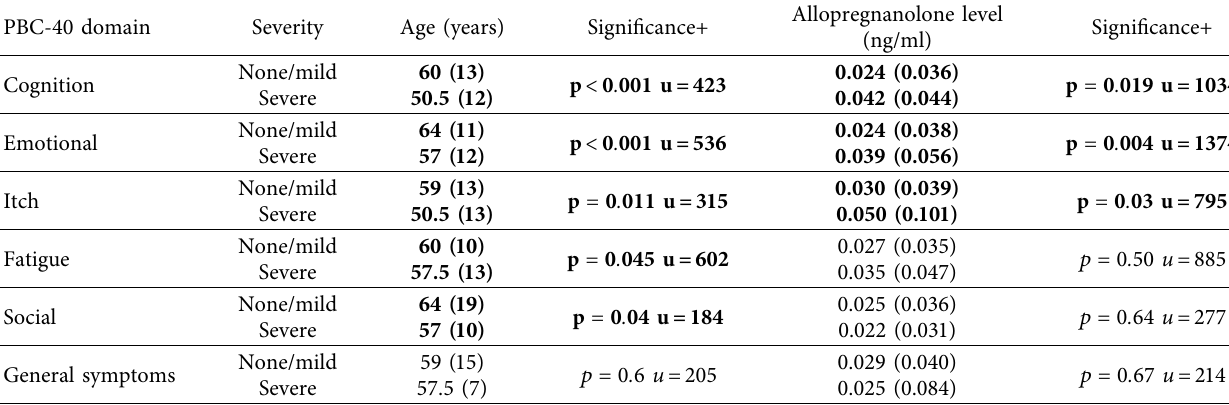
Table 3: Age (years) and allopregnanolone (ng/ml) by PBC-40